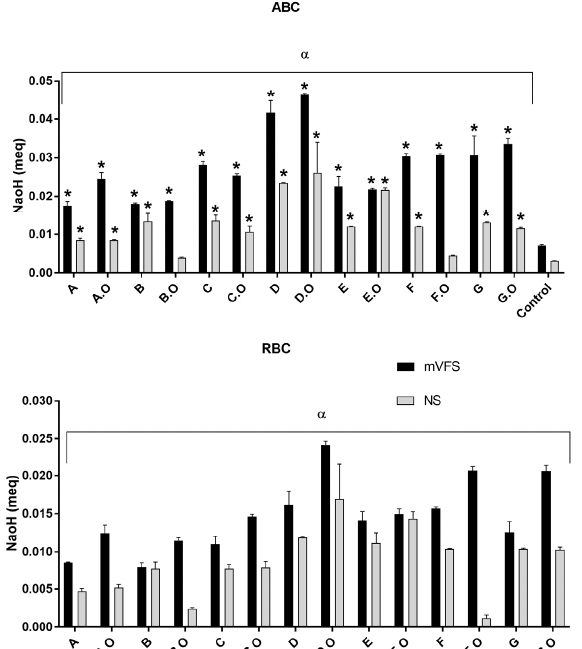
Figure 1. Determination of Absolute Buffer Capacity (part 1) and Relevant Buffer Capacity (part 2) of base formulations and sheets with TCEO. Bars represent the mean of 3 determinations and lines the standard deviation. NS = normal saline; mVFS = vaginal fluid simulant. * represents statistically significant difference from control ( p < 0.05); α represent that the mean value for each formulation is di ff erent compared to the solvent (mVFS or saline solution).